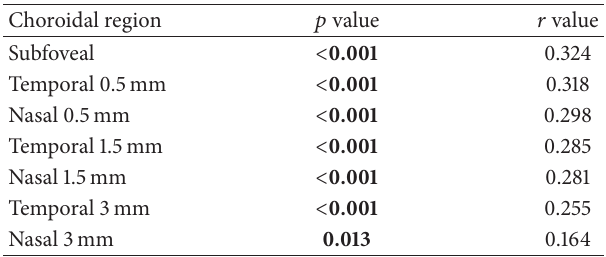
Table 3: Correlation between MMSE score and choroidal thickness at each